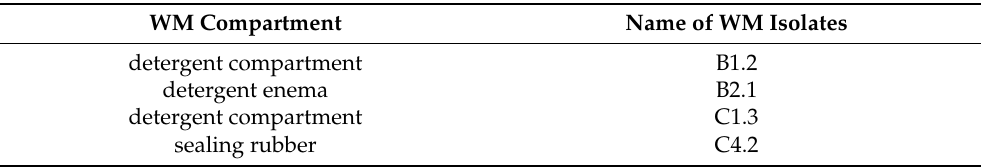
Table 1. Sampling location and name of P. aeruginosa WM isolates. The capital letters in the isolate names indicate the corresponding washing machine